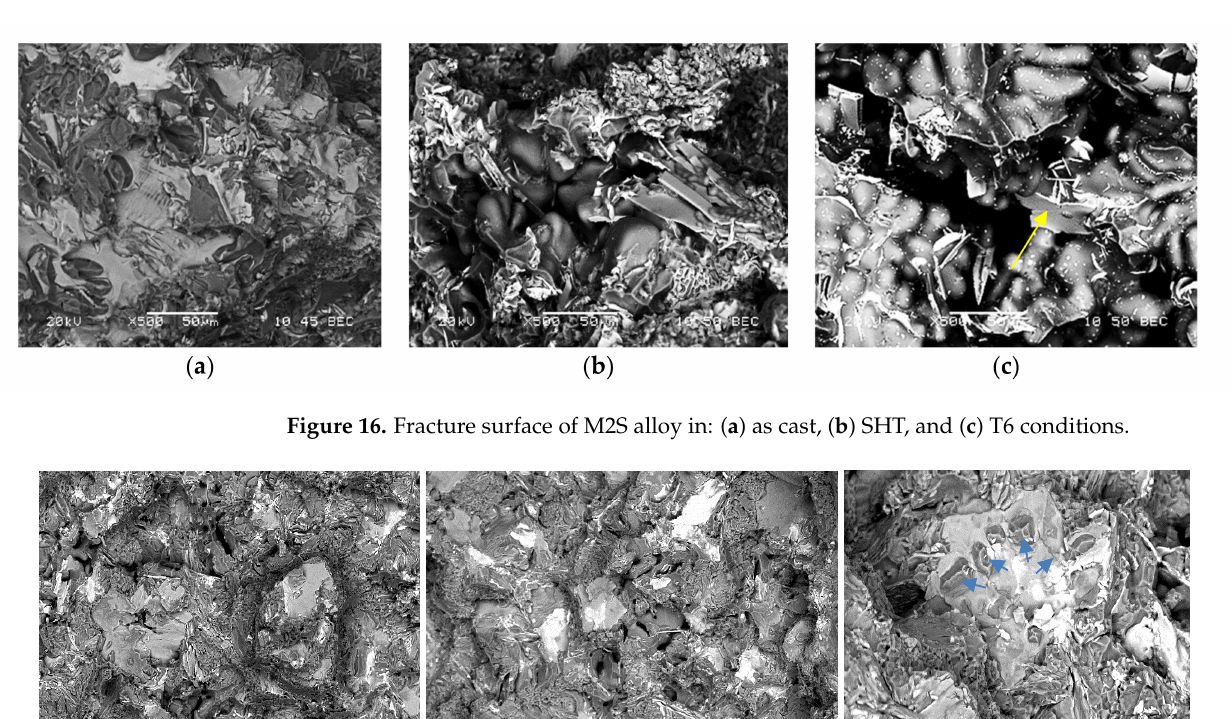
Figure 15. Fracture surface of M1S alloy in: (a) as cast, SHT, T6 conditions.